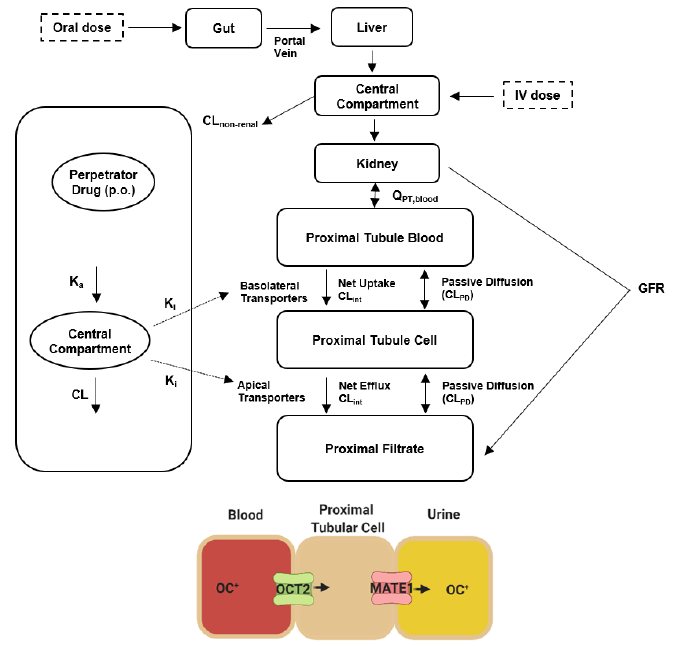
Figure 6. Structure of the physiologically based pharmacokinetic (PBPK) model for dofetilide. Ab- breviations: CL, clearance; GFR, glomerular filtration rate; OC + , organic cation; K a , absorption rate constant; K i , inhibition constant; Q, blood flow.